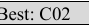
Pairwise comparison vector for the best criterion Criteria